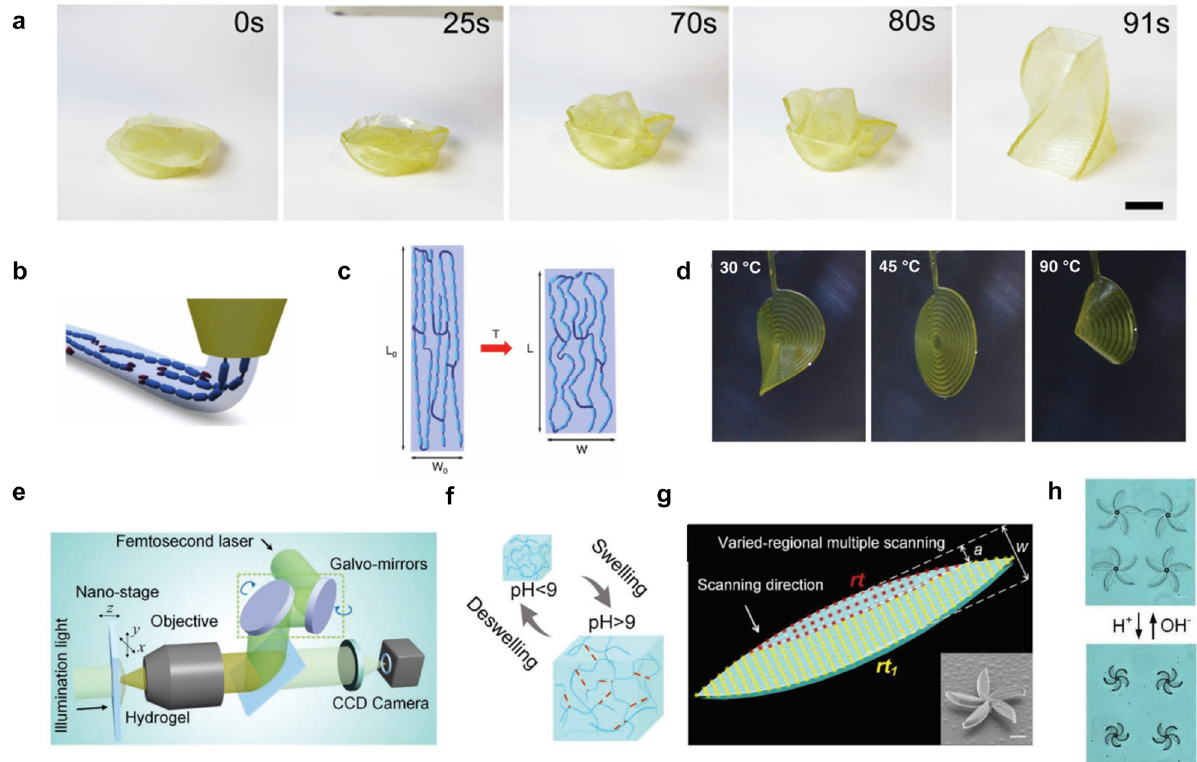
Figure 2: Representative smart materials for 4D